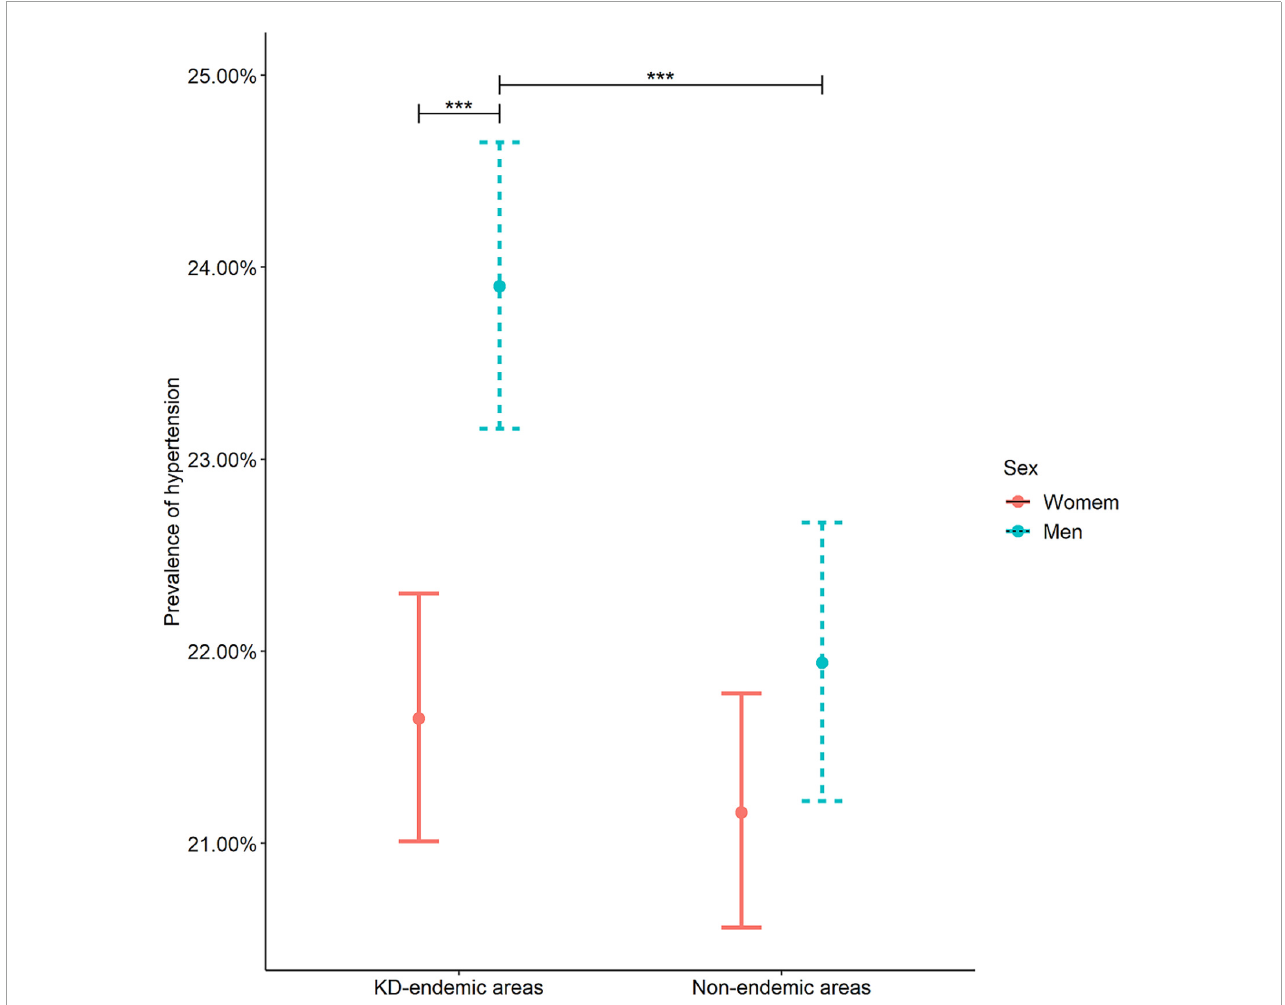
FIGURE3 Hypertension prevalence in KD-endemic and non-endemic areas by sex. Error bars with 95% CIs were used to demonstrate hypertension differences between the sexes. The prevalence was standardized by age and sex based on the 2012 China Statistical Yearbook. KD, Keshan disease; *** P < 0.001 compared with women in the KD-endemic areas or men in the non-endemic areas.